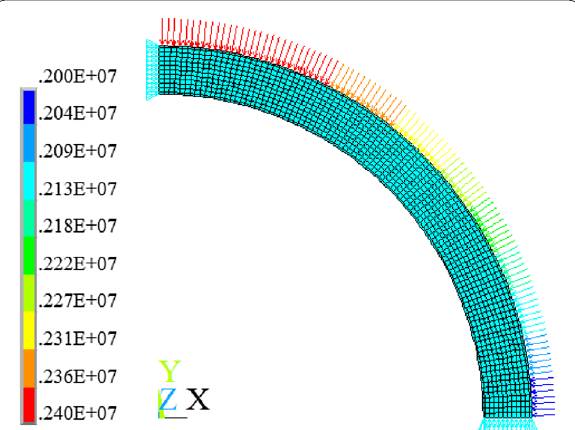
Fig. 2 Mesh generation for shaft wall model.